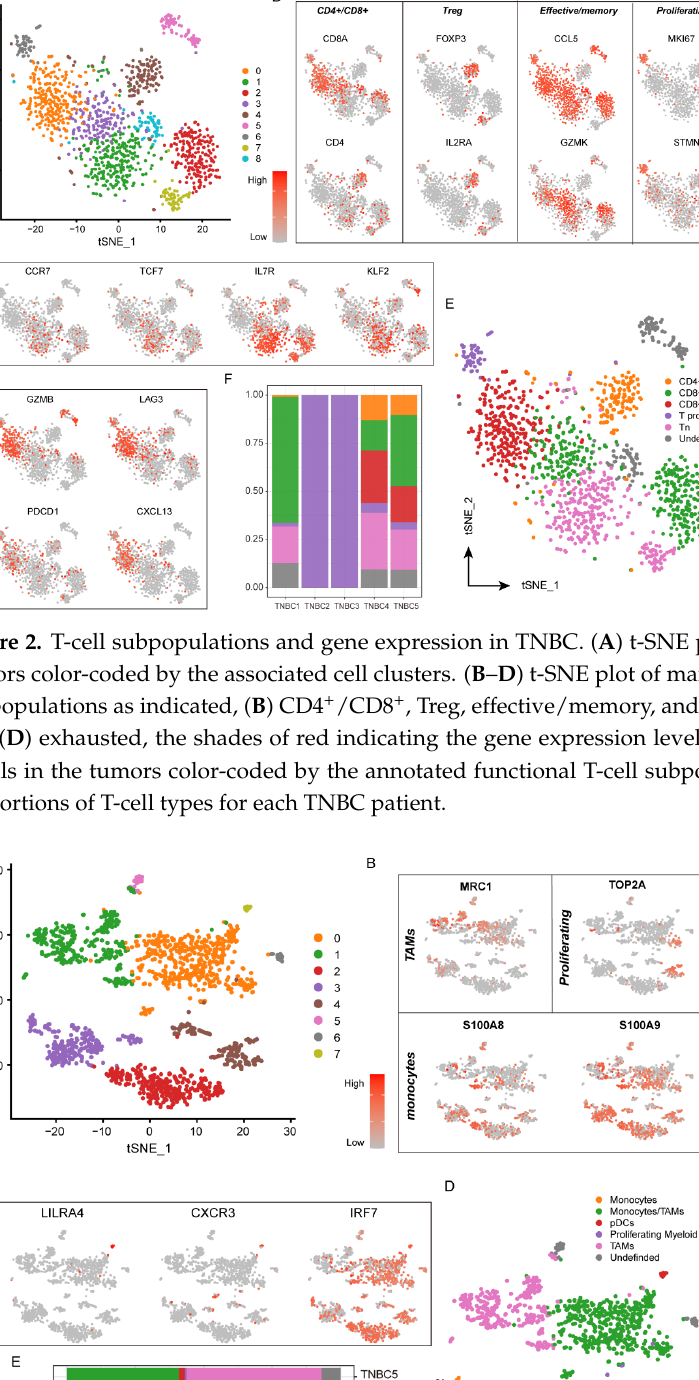
cell to attribute their EMT features (Figure 4C). A total of 888 epithelium-like and 846 mesenchyme-like malignant cells were defined, respectively. Despite there being individ- ual differences in malignant epithelial cells among the TNBC patients (Figure 4B), epithe- lium-like and mesenchyme-like malignant cells were generally found in all patients